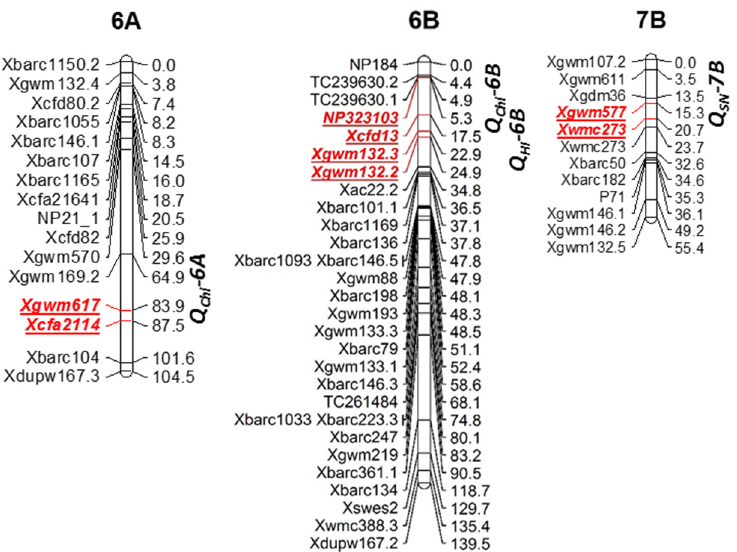
Figure 1. The distribution of the quantitative trait loci (QTL) for the investigated traits in wheat genetic linkage groups constructed on the “Xiaoyan 54 × Jing 411” recombinant inbred line population. The red text indicates marker intervals for the identified QTL. Chl, chlorophyll content; Fo, the minimum fluorescence level; Fm, the maximum fluorescence level; Fv/Fm, the maximal quantum yield of photosystem II photochemistry; PI, performance index; TRo/CS, trapped energy flux per cross section; ETo/CS, electron transport flux per cross section; DIo/CS, dissipated energy flux per cross section; RC/CSm, density of reaction center per excited cross section; A , net CO 2 assimilation rate; LAI, leaf area index; PH, plant height; SN, spike number; BM, biomass; GY, grain yield; and HI, harvest index.